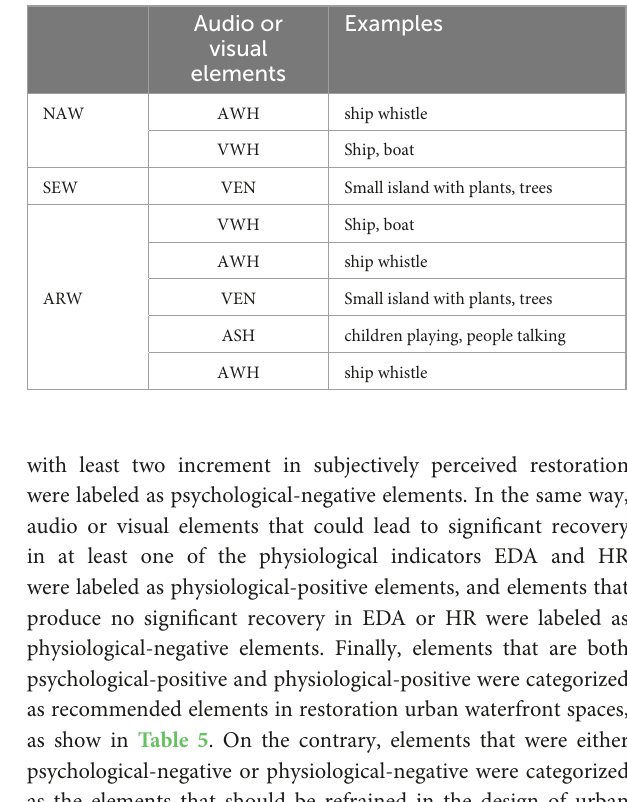
TABLE 6 Audio and visual elements that should be refrained in urban waterfront